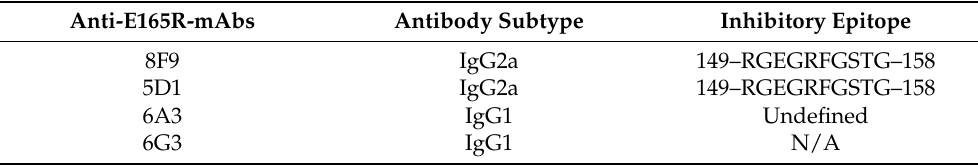
Table 3. Anti-E165R-mAbs isotyping and inhibitory epitope